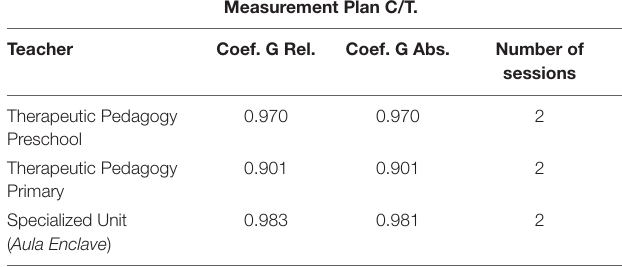
TABLE 5 | Optimization of the